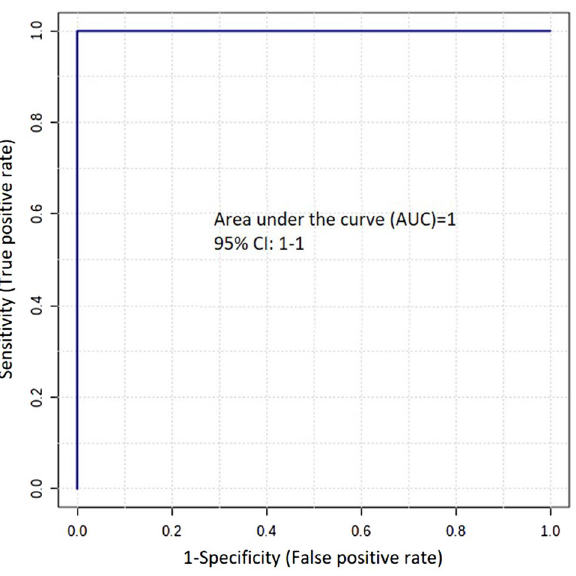
Figure 5. ROC curve of 2-arachidonylglycerol showing AUC—1.0 and sensitivity and specificity at a 95% confidence interval of